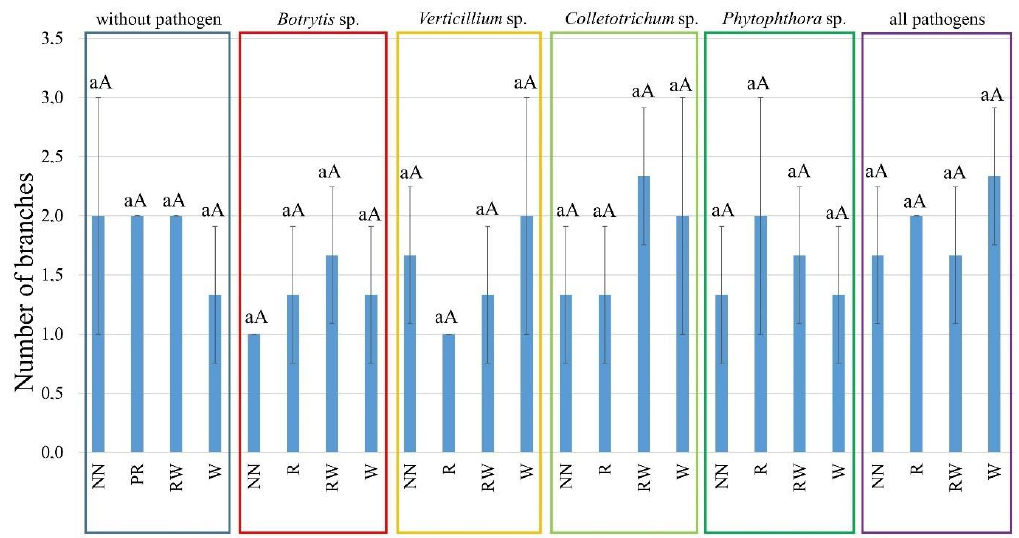
Figure A2. The early effect of the bacterial consortium on Polana raspberry plant growth in the pot experiment depended on the pathosystem and naturalization strategy applied. The average number of stems, according to pathosystems Botrytis cinerea , Verticillium sp., Colletotrichum acutatum , Phytophthora sp., and all pathogens ( Botrytis , Verticillium , Colletotrichum, Phytophthora ) and without pathogens, within different biopreparation application strategies: no naturalization (NN), root inoculations (R), root inoculations and watering (RW), and watering (W). Error bars indicate a standard deviation, n = 3, different lowercase letters above the bars indicate differences among the particular pathosystem, and different capital letters above the bars indicate differences among the particular naturalization strategies (according to ANOVA with p < 0.05). Appendix D Figure A3. The early effect of the bacterial consortium on Polana raspberry plant growth in the pot experiment depended on the pathosystem and naturalization strategy applied. The average length of the stems, according to pathosystems Bo- trytis cinerea , Verticillium sp., Colletotrichum acutatum , Phytophthora sp., and all pathogens ( Botrytis , Verticillium , Colleto- trichum , Phytophthora ) and without pathogens, within different biopreparation application strategies: no naturalization (NN), root inoculations (R), root inoculations and watering (RW), and watering (W). Error bars indicate a standard